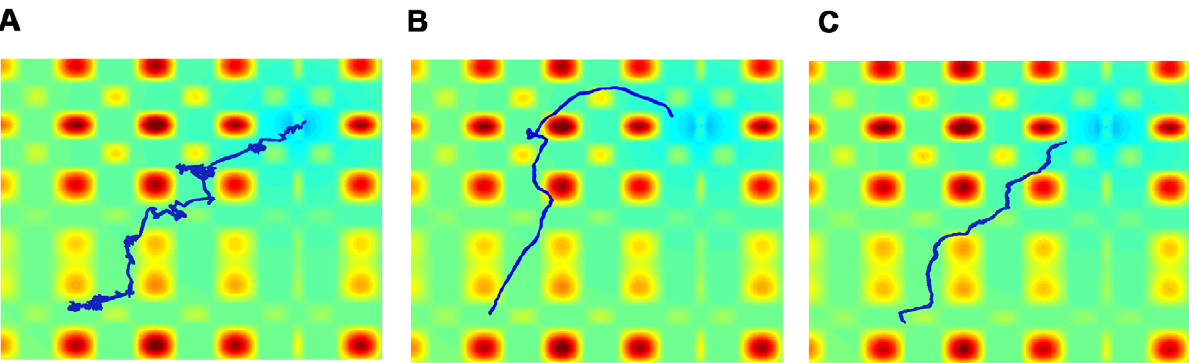
Figure 6. Examples of individual paths of agents using the different interaction mechanisms. A. The path of a single independent agent shows a biased random walk towards the target. B. The path of a single interacting agent shows directed movement towards the target with global errors. C. The path of a single agent with adaptable interactions shows directed movement towards the target with smaller global errors. Simulation parameters are as in Figure 5.